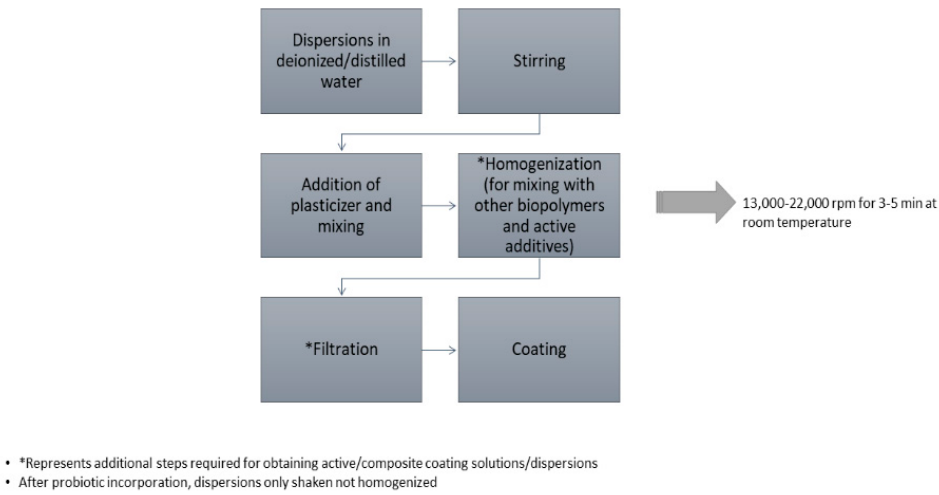
Figure 2. Process of coating development.